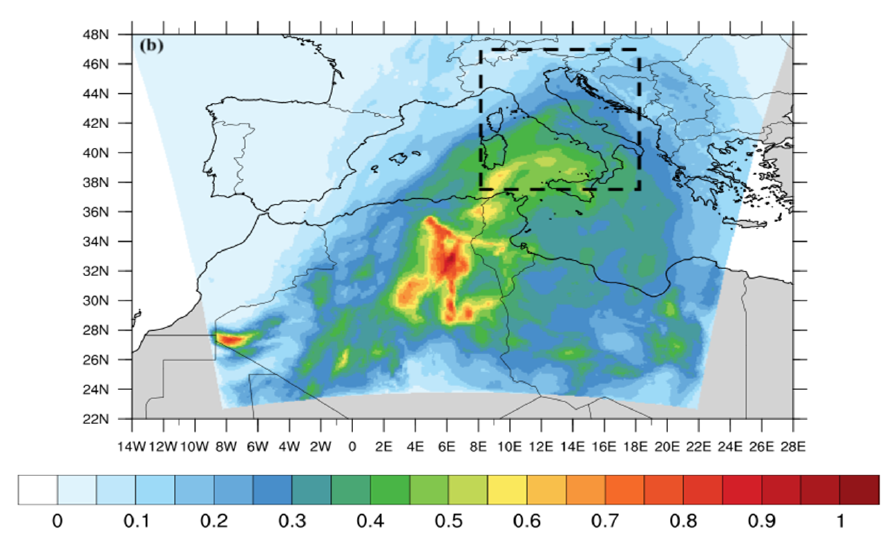
Figure 3. Full-period (17–24 June) averaged AOD from ( a ) MODIS-Aqua combined (DT + DB) algorithms and ( b ) WRF-Chem model. Spatial average is calculated in the squared do tt ed box.